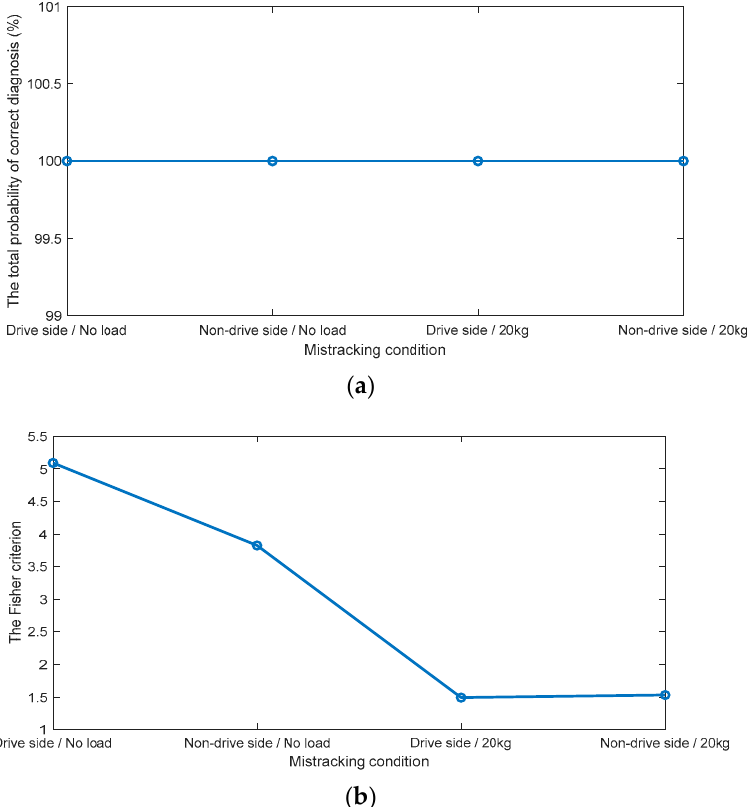
Figure 10. ( a ) The total probabilities of correct diagnosis (%), provided by the CCSM3 ( b ) The Fisher criteria for the CCSM3.